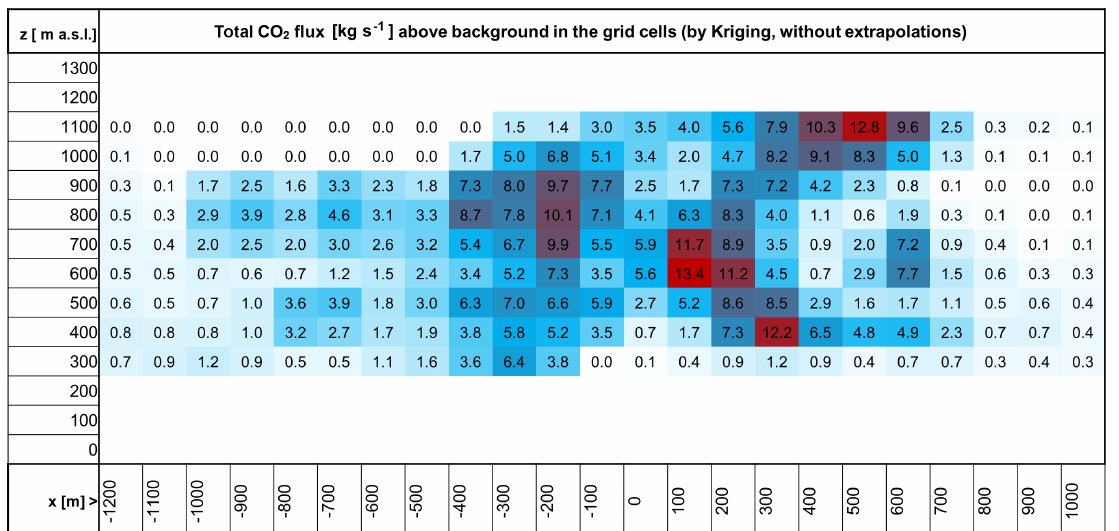
Figure 6. The same as Fig. 4 but for the CO 2 flux calculated by kriging of the original data instead of averaging in cells and applying our method for linear inter- and extrapolations. The kriging was only done for the part of the cross section with layers containing data. The comparison with our standard method (see Supplement) was done by adding the percentage of the extrapolated flux (up to the stable layer and down to the surface) of the standard method ( + 10% in this case).